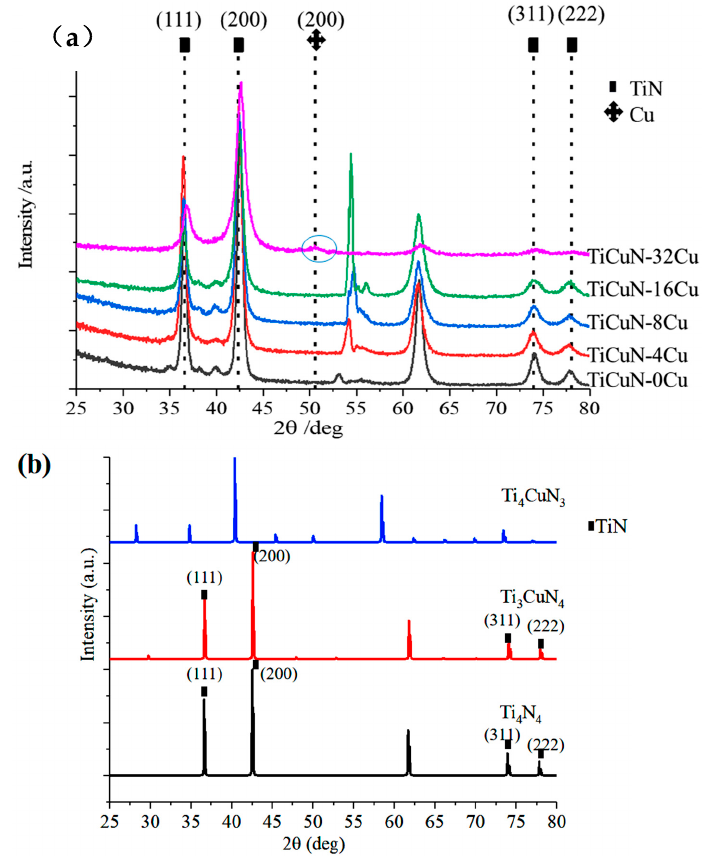
Figure 4. XRD spectrum of TiCuN films with different Cu contents ( a ) experimental XRD spectrum; and ( b ) simulated XRD spectrum. Table 3. Half width and height of TiCuN films with different Cu contents.